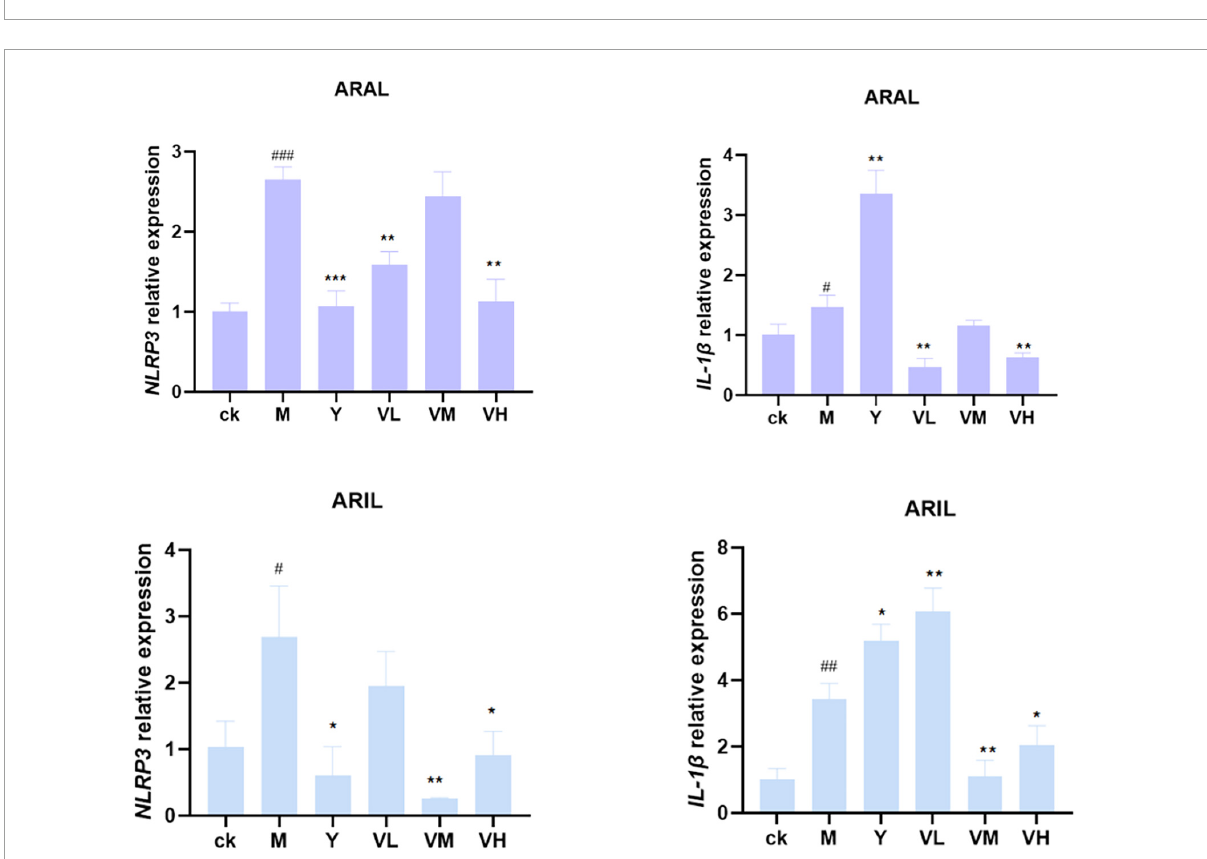
FIGURE13 Relative expression of NLRP3 and IL-1 β mRNA in RAW264.7 cells. After administration, NLRP3 and IL-1 β mRNA expression decreased (mean ± SD , n = 3 ). *** P < 0.001, ** P < 0.01, * P < 0.1 compared with that of the LPS group; ### P < 0.001, ## P < 0.01, # P < 0.1 compared with that of the control